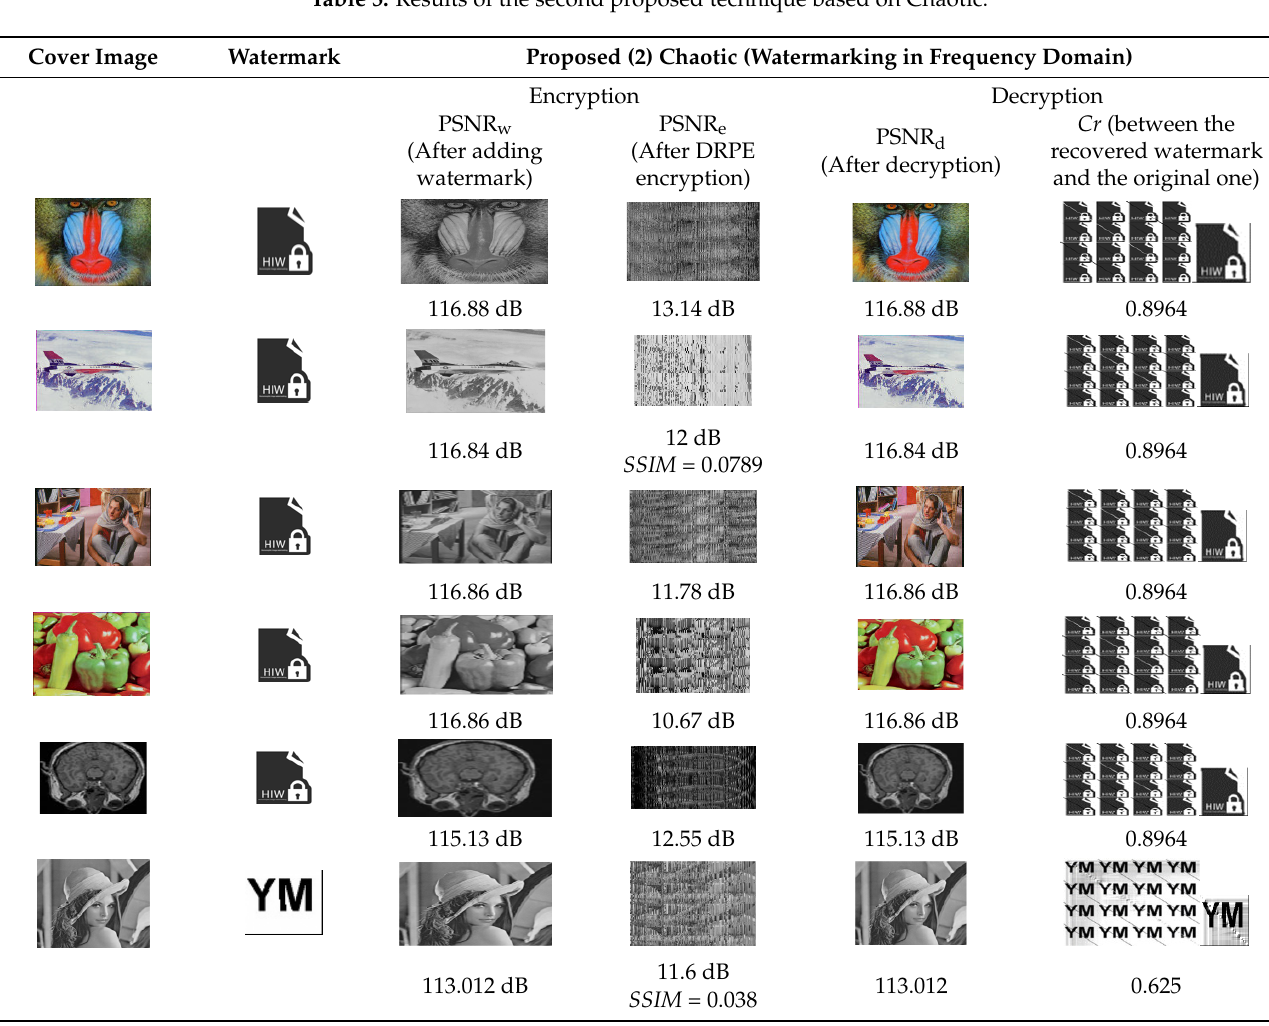
Table 5. Results of the second proposed technique based on Chaotic.